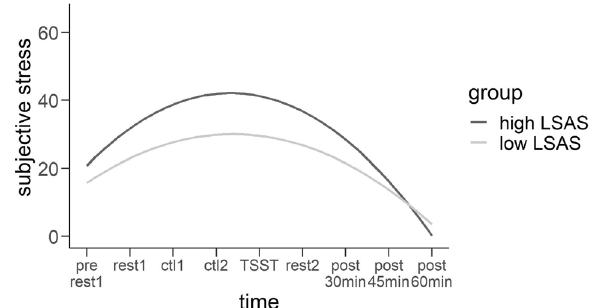
Figure 1. Predicted subjective stress ratings (VAS) in percent dependent on time according to the estimated parameters of the regression model including LSAS (rest1 = resting-state measurement 1, ctl1 = control task 1, ctl2 = control task 2, TSST = stress induction, rest2 = resting-state measurement 2). The significant interaction effect of LSAS and time has been categorized into low and high total scores (± 1 SD) for reasons of clearer visualization.